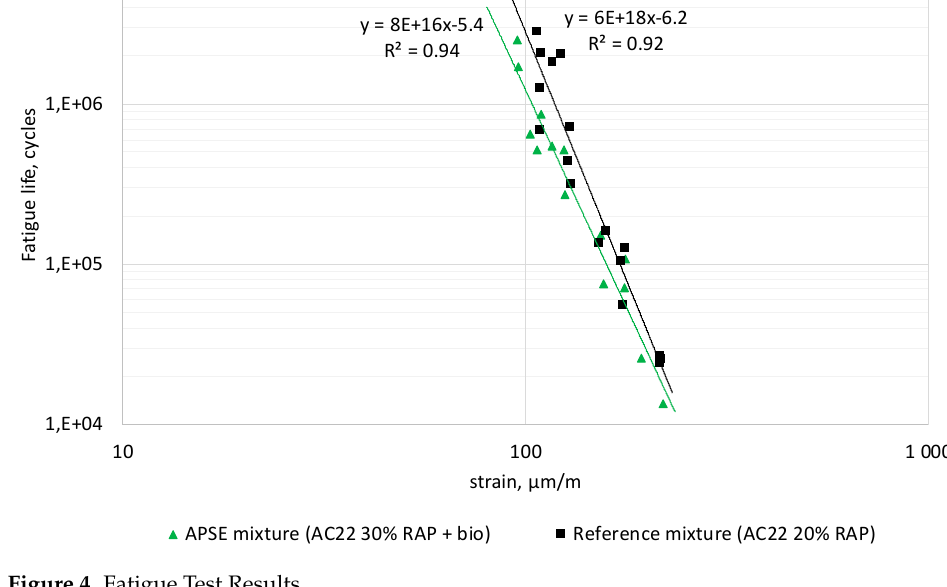
Figure 4. Fatigue Test Results.